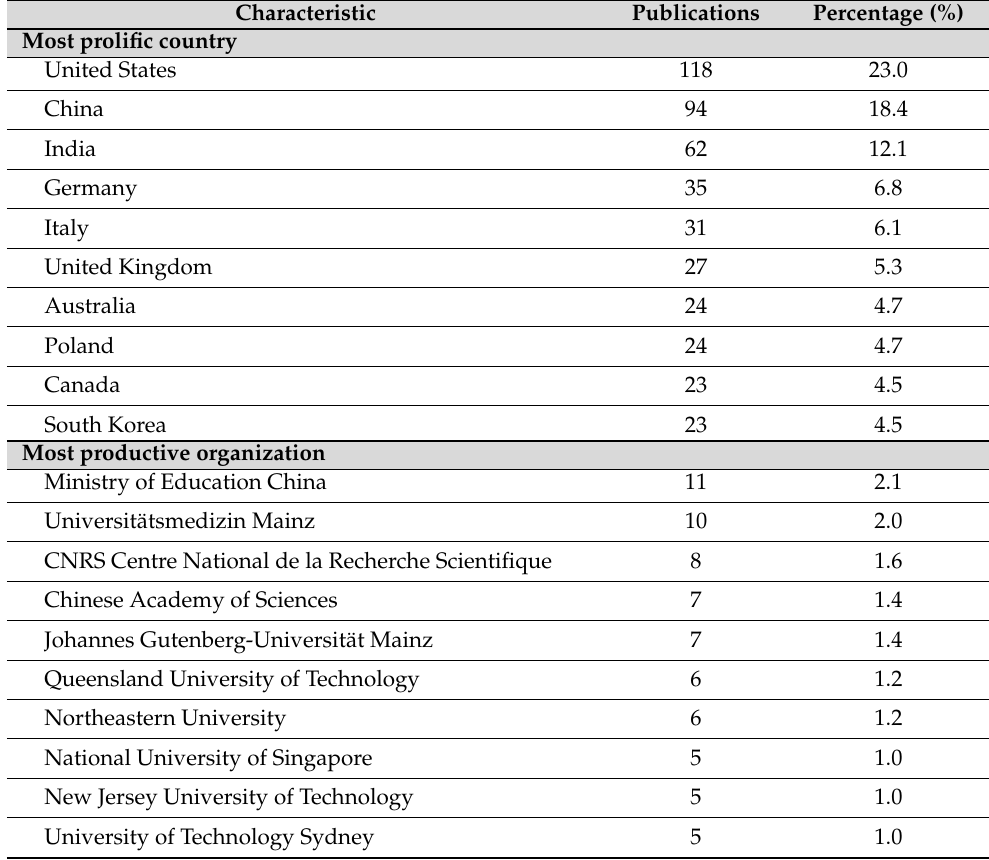
Table 2. Top 10 most prolific countries, productive organizations, and funding sources of polymer research related to